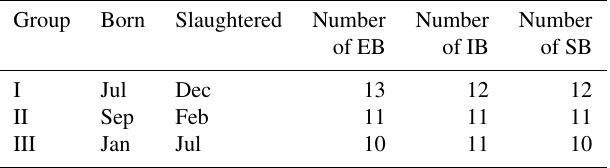
Table 1. Description of the experimental animals, divided into three experimental groups (I–III).